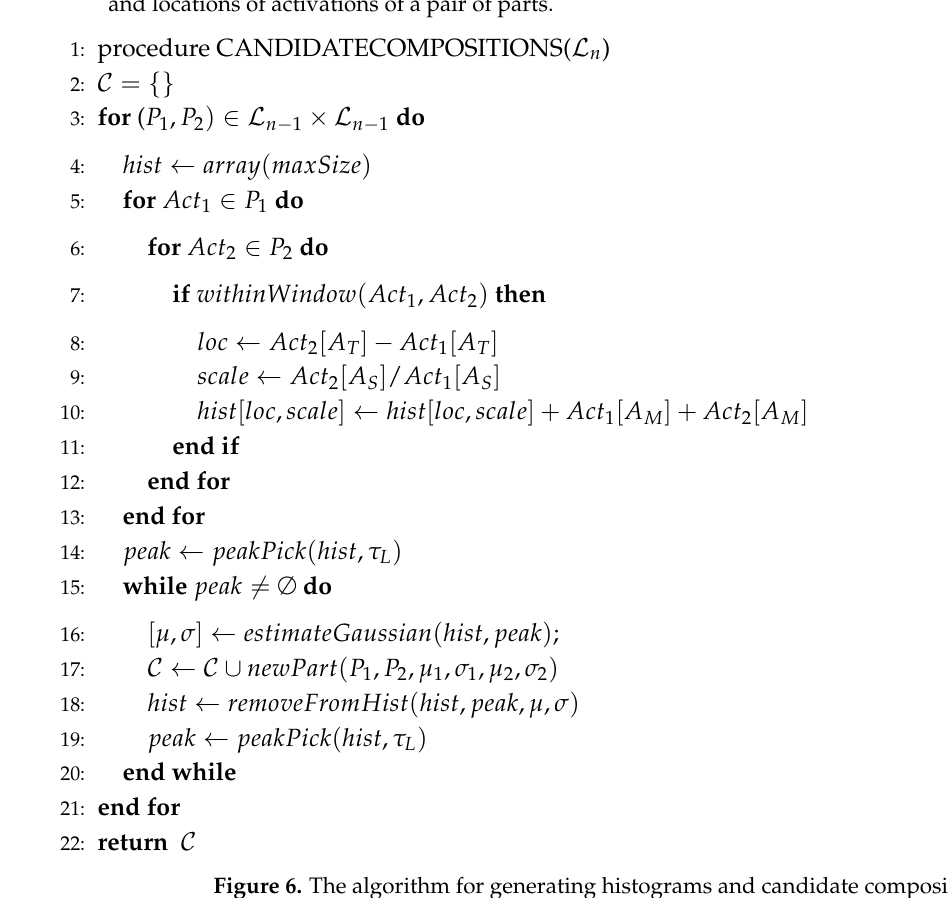
Figure 6. The algorithm for generating histograms and candidate